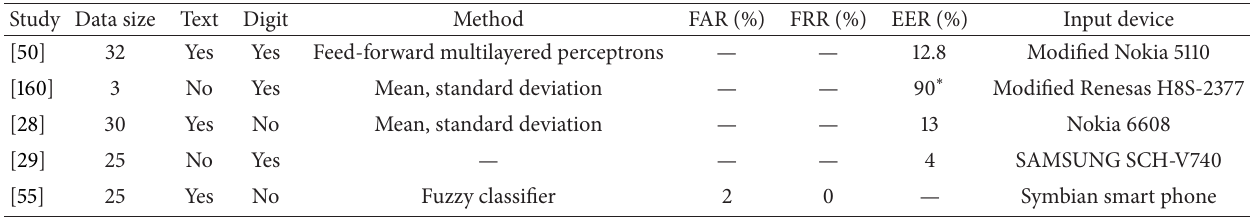
Table 8: Comparison between research works performed on mobile platform.